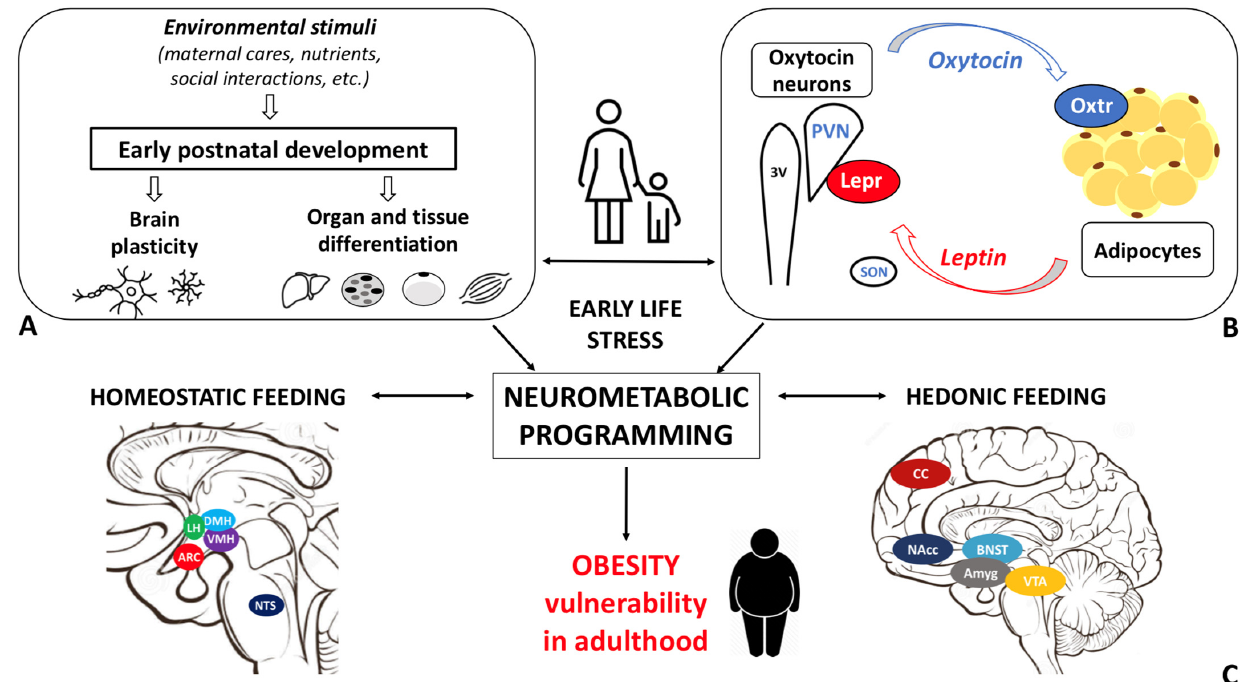
Figure 5. Schematic representations of the pathways linking early life stress to vulnerability to adult obesity. ( A ) Impact of environmental stimuli on the early postnatal development of various organs (e.g., brain, liver, brown and white adipose tissues, and skeletal muscle). ( B ) Oxytocin (Oxt), produced in the paraventricular nucleus (PVN) and supraoptic nucleus (SON) of the hypothalamus, regulates maternal bonding, stress response, and energy homeostasis. Oxt receptor (Oxtr) is highly expressed in white adipose tissue. Adipocytes are the main source of leptin (Lep), the master energy balance regulator, whose receptor (Lepr) is expressed in Oxt neurons. ( C ) Early adverse experiences may affect brain development, metabolically relevant organs differentiation, and the Oxt and Lep systems maturation. In this condition, dysfunctional neurometabolic programming and homeostatic and hedonic feeding centers maturation may occur, ultimately enhancing the vulnerability to obesity